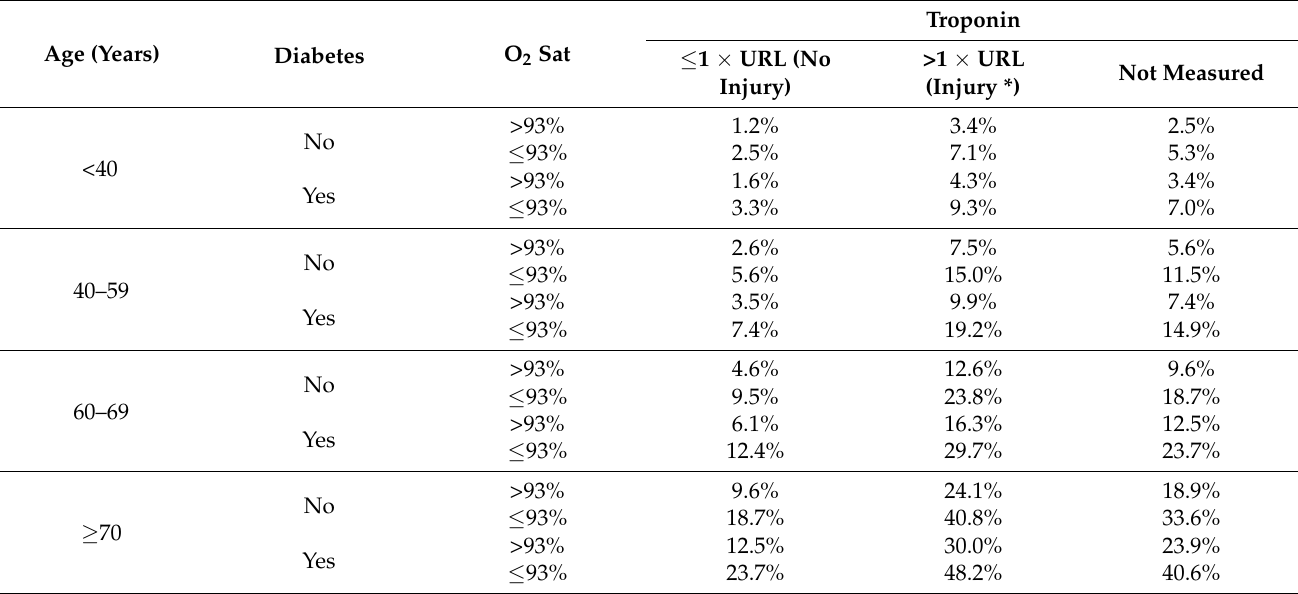
Table 5. Probability of death according to the final logistic regression model ( n =